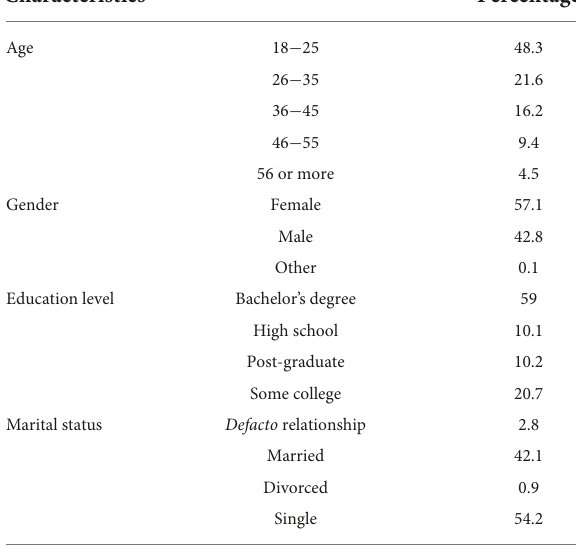
TABLE 3 Profile of respondents ( N =